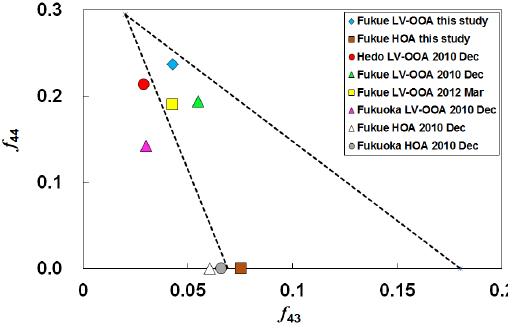
Figure 4. Plot of f 44 versus f 43 for different types of organic aerosols extracted from PMF analysis. Dashed lines are the limits of oxidation states reported by Ng et al.